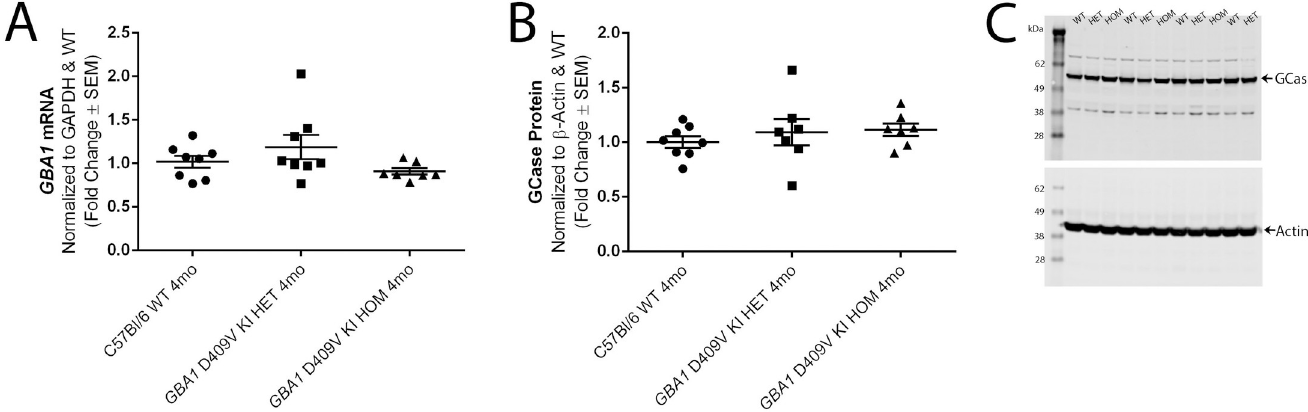
Fig 2. Introduction of the D409V point mutation to the GBA1 gene does not affect GBA1 mRNA transcription or GCase protein translation. (A) GBA1 mRNA levels assessed by qPCR in frontal cortex tissue from 4 month old C57Bl/6 wild type (WT) mice, GBA1 D409V KI heterozygous (HET) mice, and GBA1 D409V KI homozygous (HOM) mice. GBA1 mRNA levels are normalized to GAPDH as the housekeeping gene, with graphs depicting fold changes relative to WT expression levels. GBA1 mRNA levels are consistent between groups with no significant differences observed (n = 8/group; p > 0.05). WT levels measure 1.016 ± 0.068, HET levels measure 1.185 ± 0.140, HOM levels measure 0.9066 ± 0.037. (B-C) GCase protein levels assessed by Western blot in forebrain tissue (caudal to frontal cortex) from the same mice used for mRNA analysis. (B) GCase protein levels are normalized to β -actin as the housekeeping protein, with graphs depicting fold changes relative to WT GCase protein expression levels. GCase protein is unchanged in the HET and HOM GBA1 D409V KI mice as compared to WT (n = 7-8/group; p > 0.05). WT levels measure 1.000 ± 0.052, HET levels measure 1.091 ± 0.120, HOM levels measure 1.114 ± 0.057. (C) Representative image of Western blot results for alternating samples of WT, HET, and HOM GBA1 D409V KI mice. Abbreviations: SEM, standard error of the mean; WT, wild type; GBA1 , gene encoding human glucocerebrosidase; GCase, glucocerebrosidase; KI, knockin; HET, heterozygous; HOM, homozygous; mo, month.